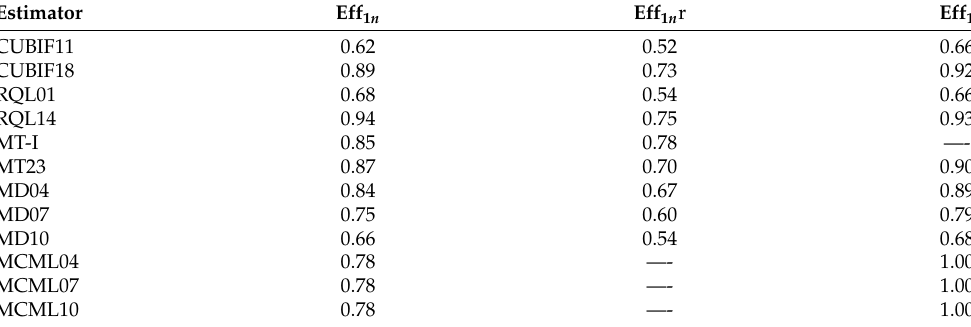
Table 1. Efficiencies of the robust Poisson regression candidates: Eff 1 n is the empirical efficiency based on complete data; Eff 1 n r is the empirical efficiency based on cleaned data; Eff 1 is the asymptotic effi- ciency. CUBIF, conditionally unbiased bounded influence estimator; RQL, robust quasi-likelihood estimator; MT, transformed M estimator; MD, minimum density power divergence estimator; MCML, modified conditionally maximum likelihood